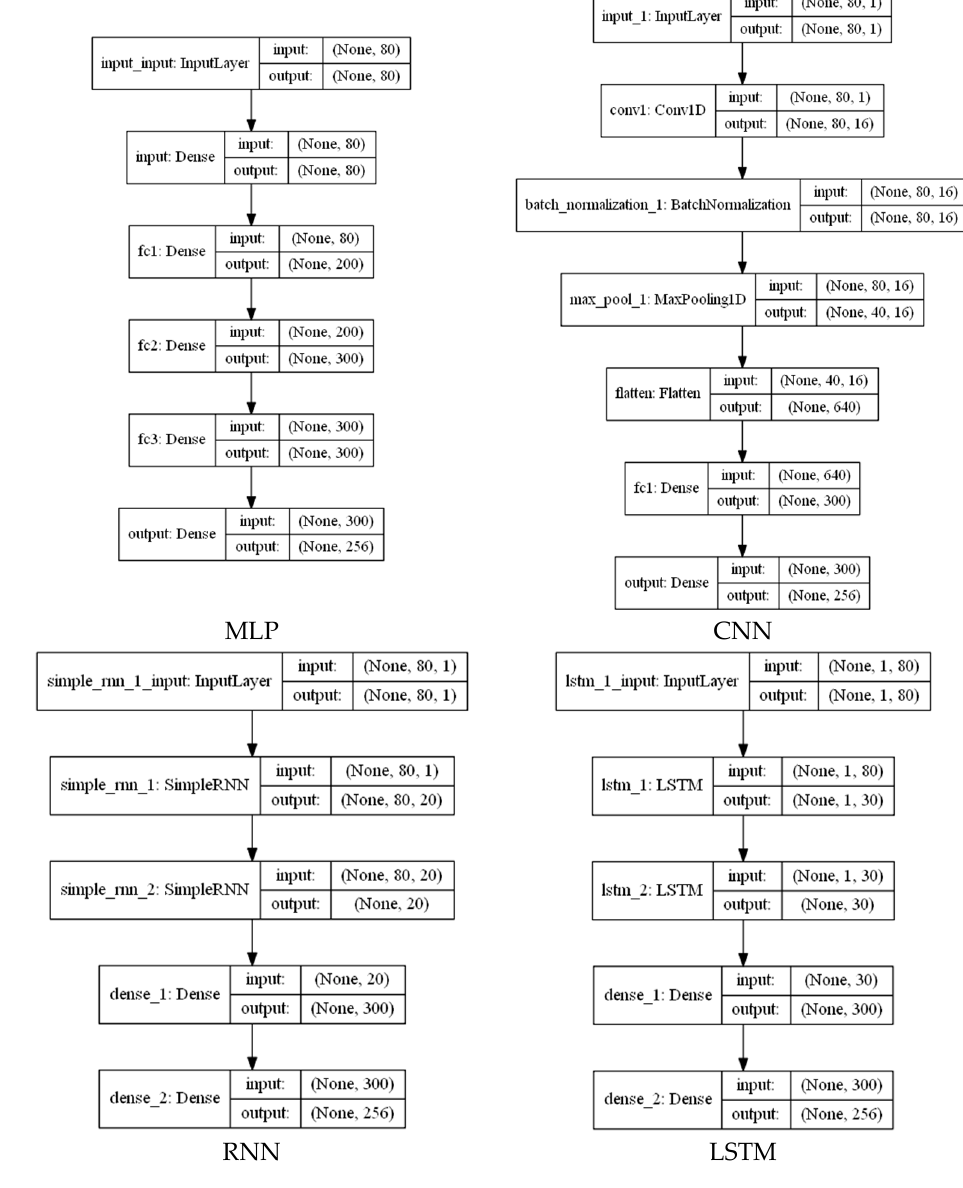
Figure 10. Four model structures.